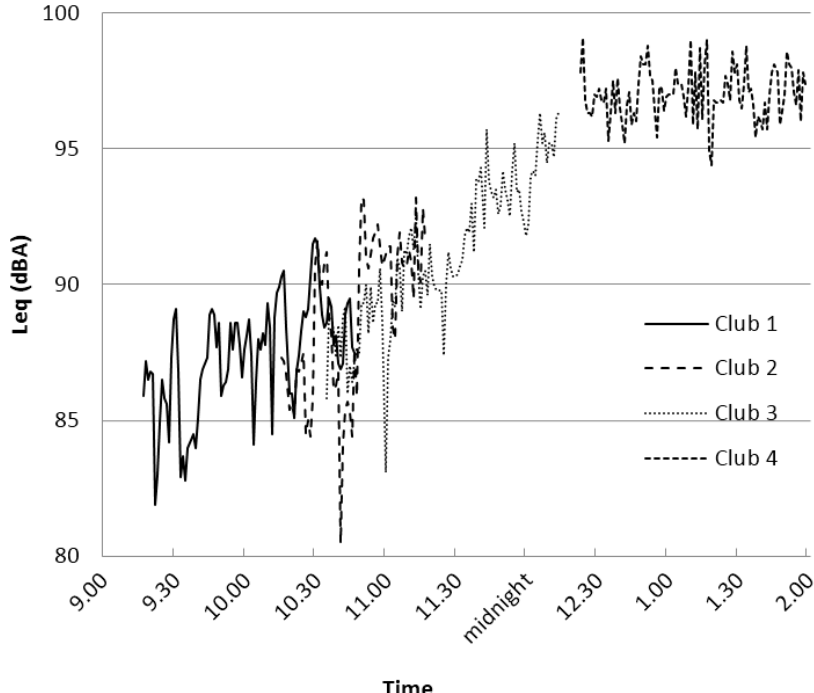
Figure 1. Music level (dBA Leq) per minute measured in four different Auckland clubs.